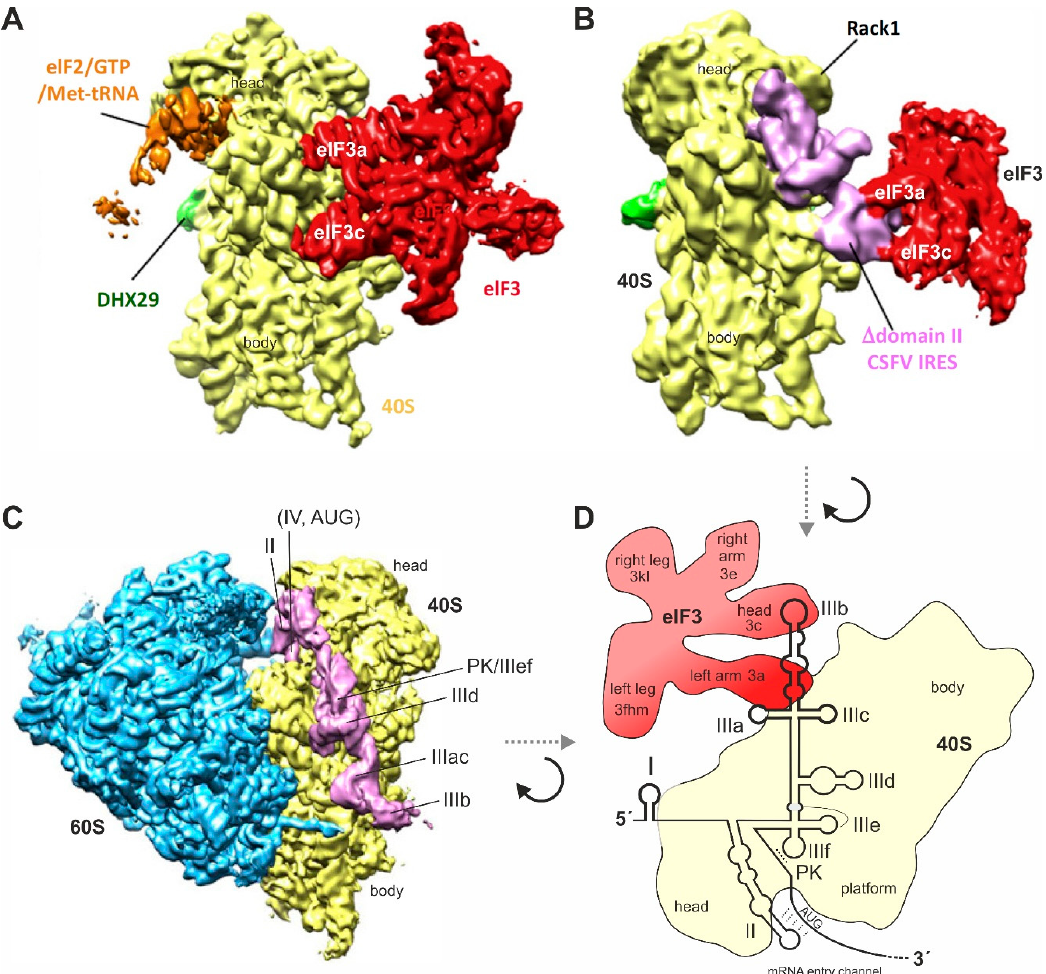
Figure 4. Binding of the HCV IRES to the ribosome and to eIF3. ( A ) The small ribosomal 40S subunit (yellow) with bound eIF3 (red). eIF3 makes multiple contacts to the 40S subunit using several subunits, including eIF3a and eIF3c; ( B ) The IRES of classical swine fever virus (CSFV) (pink) without IRES domain II, binding to the 40S subunit (yellow) and to eIF3 (red). The IRES has displaced eIF3 completely from its binding to the 40S subunit (compare panel A) but keeps it connected to the 40S subunit only indirectly by contacts between IRES SL IIIabc and eIF3. Figures A and B were reprinted from [150] (Figure 2F) and slightly modified. Reprinted with permission from Elsevier (licence no. 4761840166773); ( C ) The HCV IRES (pink) binding to the 40S subunit (yellow) in the complete 80S ribosome (60S subunit in blue). The IRES SL IIIdef/PK is in close contact with the 40S subunit, the SLs II and IV are positioned in the mRNA entry channel, and the SL IIIb is pointing to the solvent side for binding eIF3. The IRES is not touching the 60S subunit [121,138]. Figure C was modified from the left panel of Figure 1C in [121]. Reproduced with permission from EMBO; ( D ) Schematic illustration of the HCV IRES binding to the 40S subunit (yellow) and to eIF3 (red) when eIF3 is largely displaced from the 40S subunit by the IRES, similar as in (B). The orientation of the 40S subunit is shown essentially top-down as compared with (A–C), viewed approximately from the solvent side.